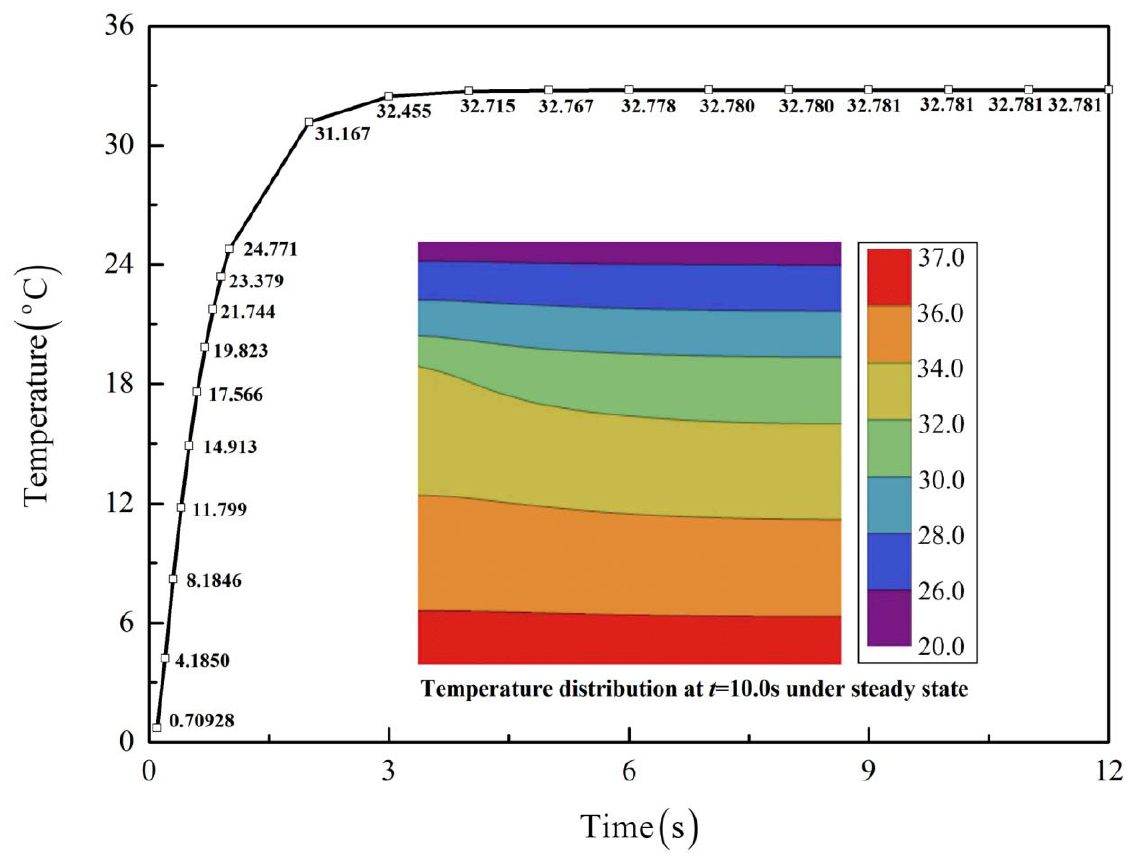
Figure 5. Time-dependent temperatures for Case 1 at ( a /2, a /2), with the inset showing the temperature distribution under steady state.